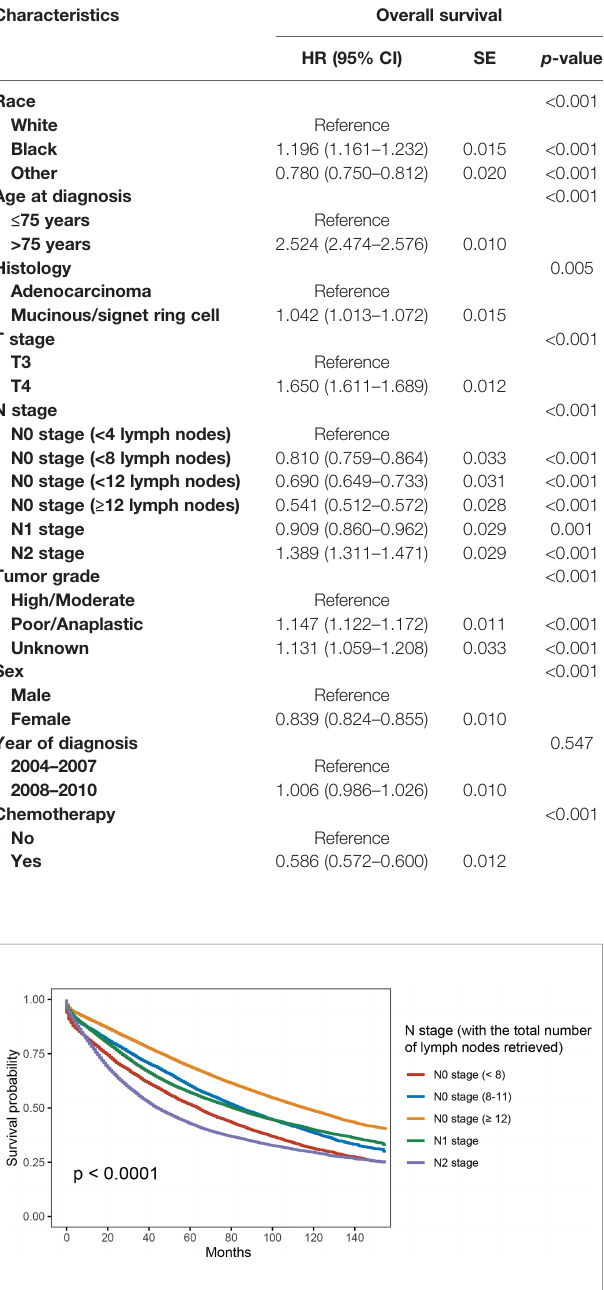
FIGURE 3 | Kaplan – Meier survival curves for colon cancer patients according to the number of lymph node retrieved (with the combination of less than four lymph nodes and less than eight lymph nodes examined together).